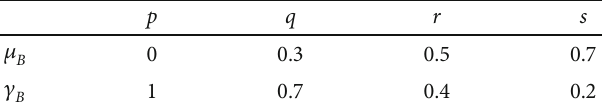
Table 32: Intuitionistic fuzzy set B